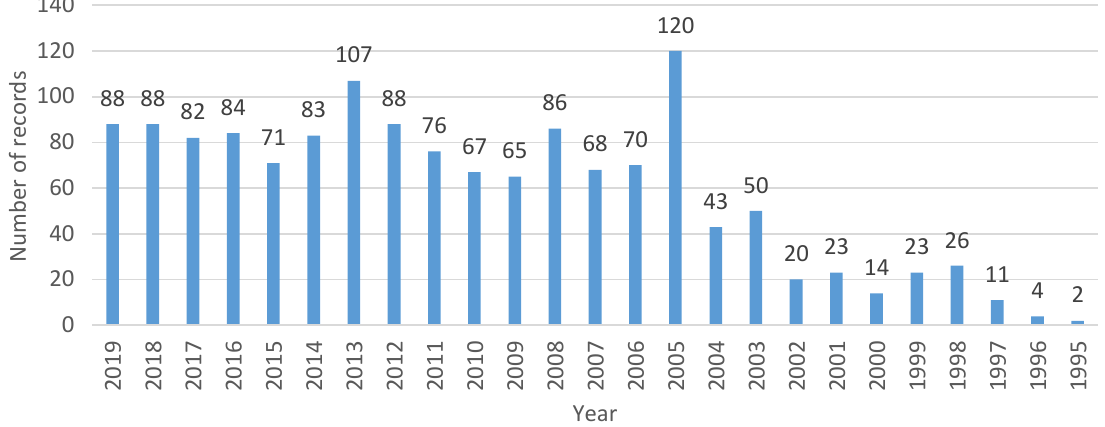
Figure 1. Number of publications with the term “Earnings Management”